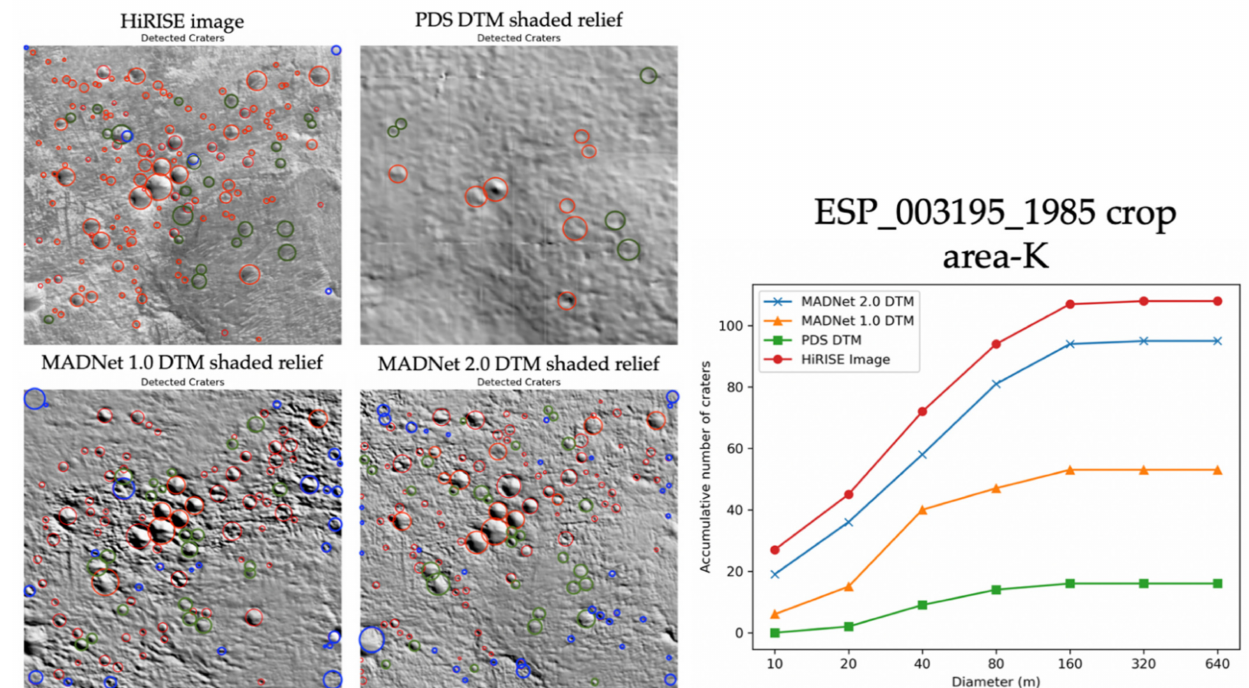
Figure 16. Crater detection and size-number counting from HiRISE image and the hill-shaded relief images of the PDS DTM, MADNet 1.0 DTM, and MADNet 2.0 DTM, over a 250 m × 250 m cropped area (area-K of ESP_003195_1985_RED). N.B. automatically detected craters are in red circles; manually excluded false-positives are in blue circles; manually added true-positives are in green circles.